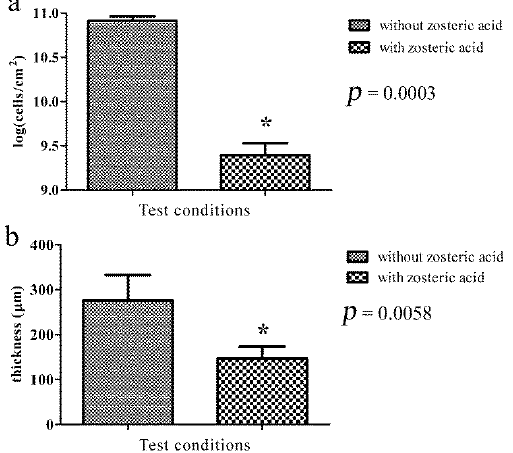
Figure 4. Effect of zosteric acid on the amount of P. putida sessile cells on polycarbonate membranes ( a ) and on the thickness of cryosectioned P. putida biofilm ( b ). Data represent the mean ± standard deviation of replicates; * statistically significant difference at the 95% confidence level between control and treated samples.